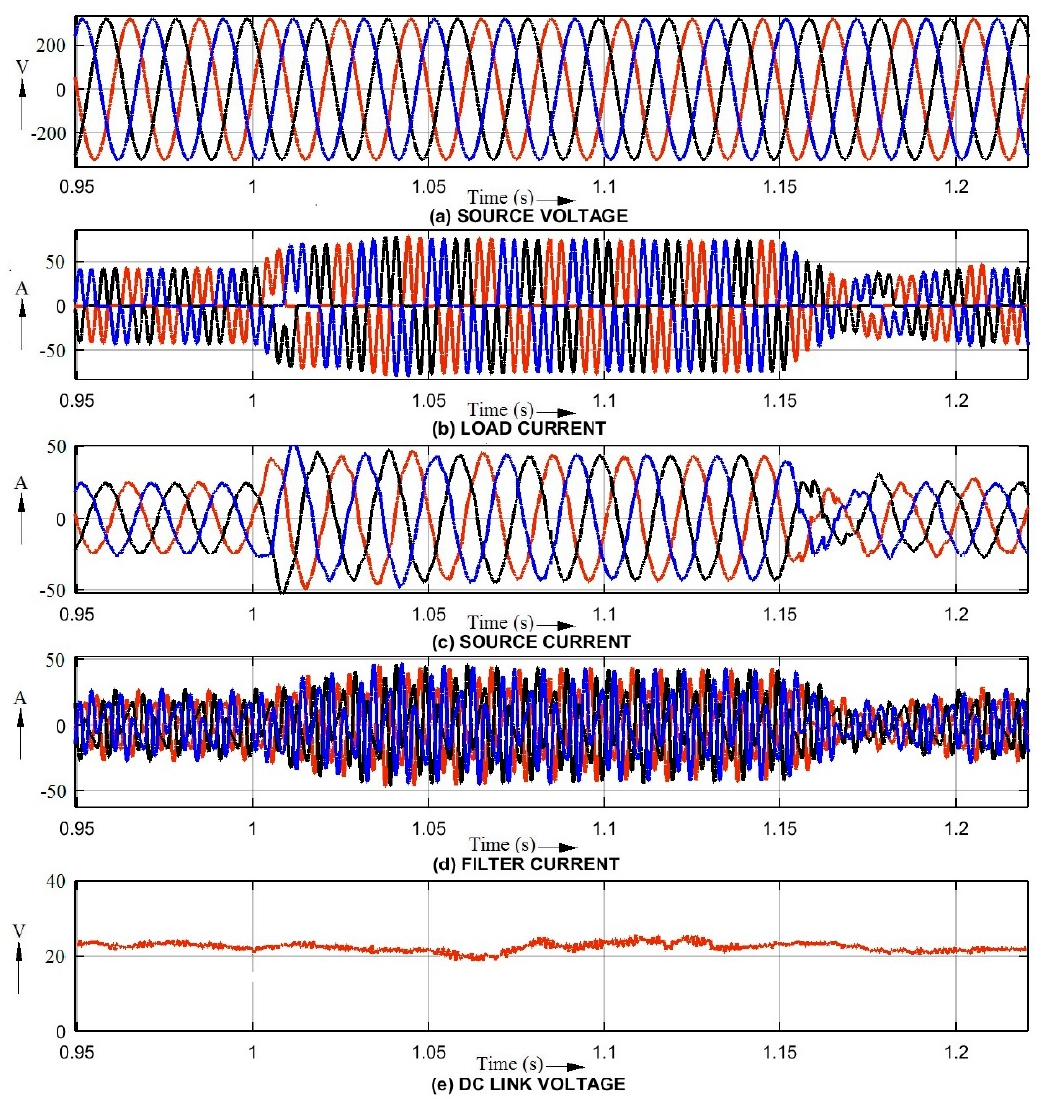
Figure 9. Performance of the compensator for variation in three-phase rectifier-fed RC load.